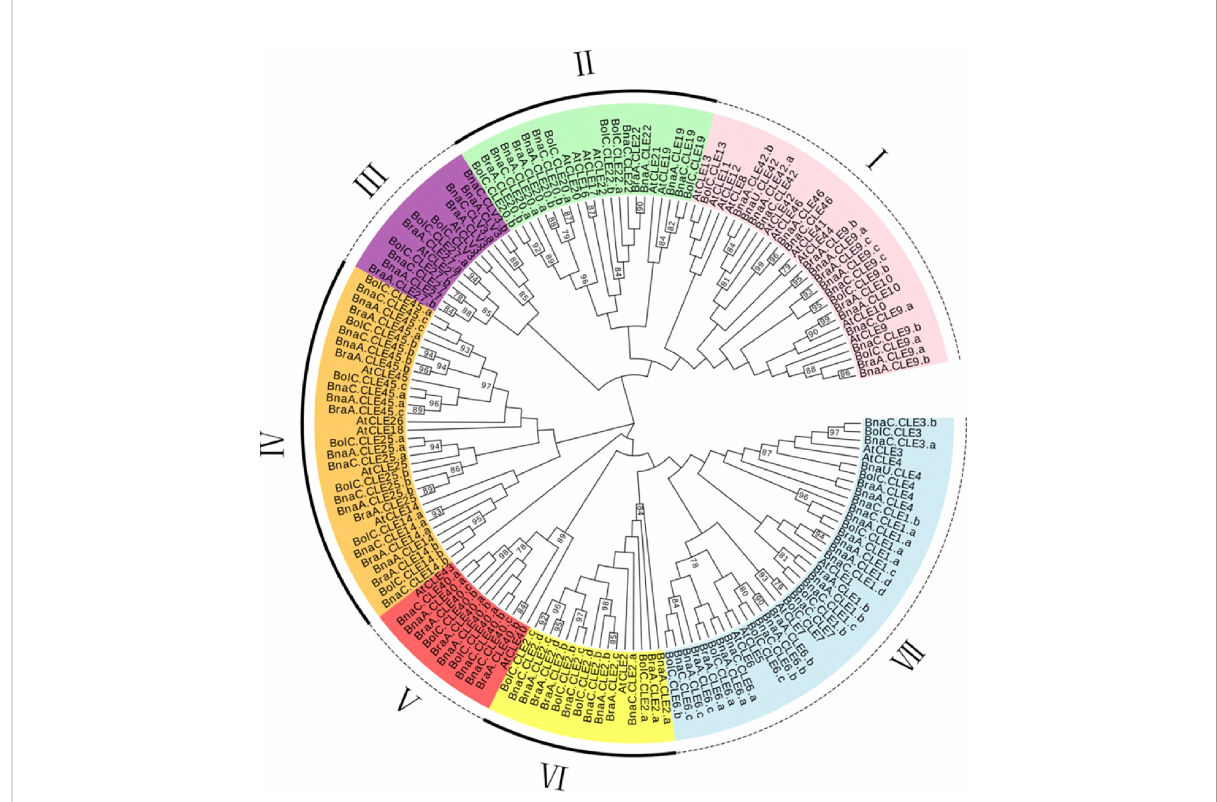
FIGURE 1 Phylogenetic analysis of Brassica napus , Arabidopsis thaliana , Brassica rapa , and Brassica oleracea CLE genes. This unrooted phylogenetic tree was constructed by MEGA 7.0 using the maximum likelihood method with 1,000 bootstrap replicates. Only values above 50% were